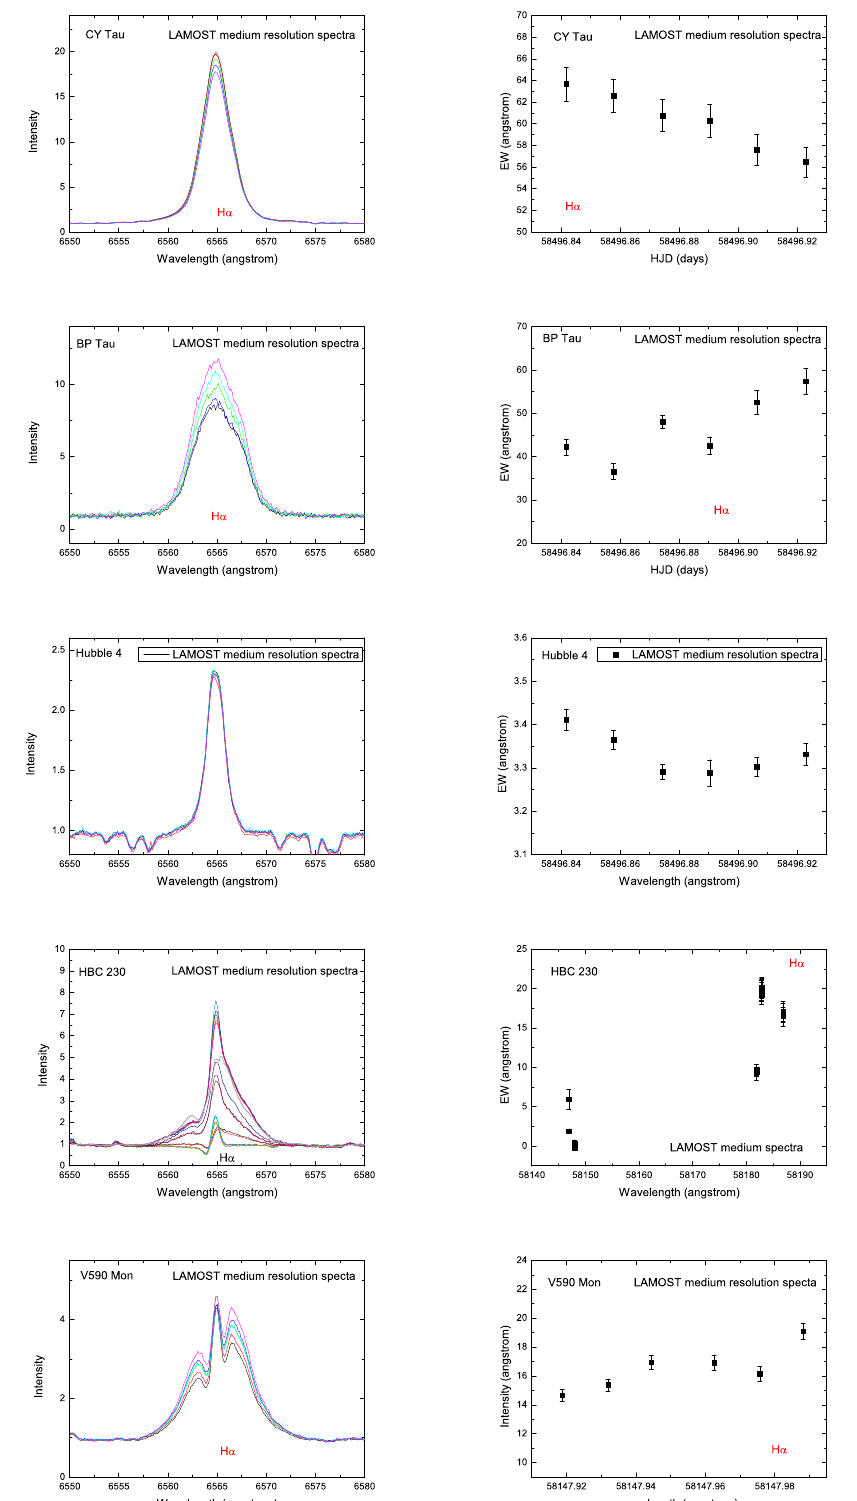
Figure 6. Medium resolution LAMOST spectra of radio stars with repeated observations on short time scale ( left ). The short-term variation of EW is shown on the ( right